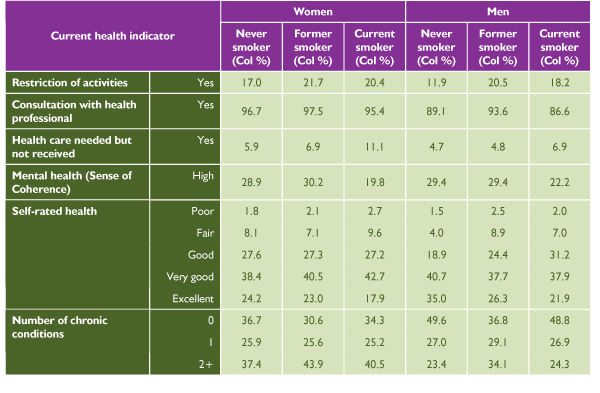
Current Health Indicators for Never Smokers, Former Smokers and Current Smokers, by sex (NPHS 1998–1999)